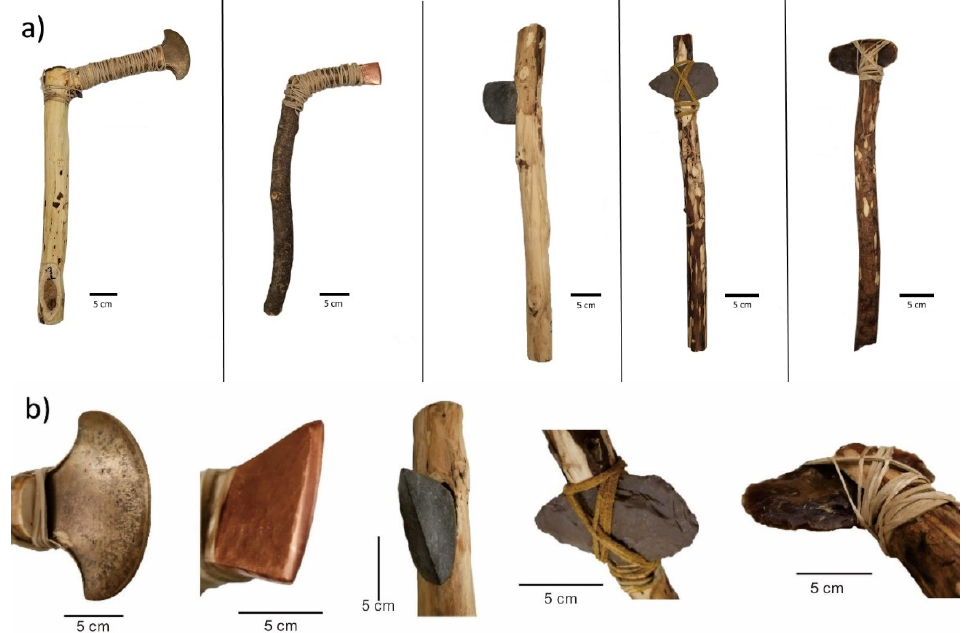
Figure 1. ( a ) The five experimental axes (left to right): bronze, copper, ground stone, chert chipped stone, and Knife River Flint chipped stone; and ( b ) close-up of the same axe heads in the same order as above.